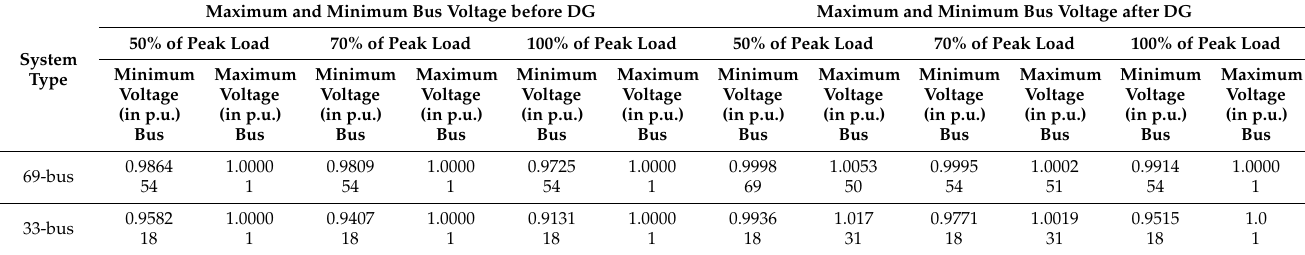
Table A4. Maximum and minimum value of voltage for IEEE 69-bus and IEEE 33-bus network before and after dg placement.